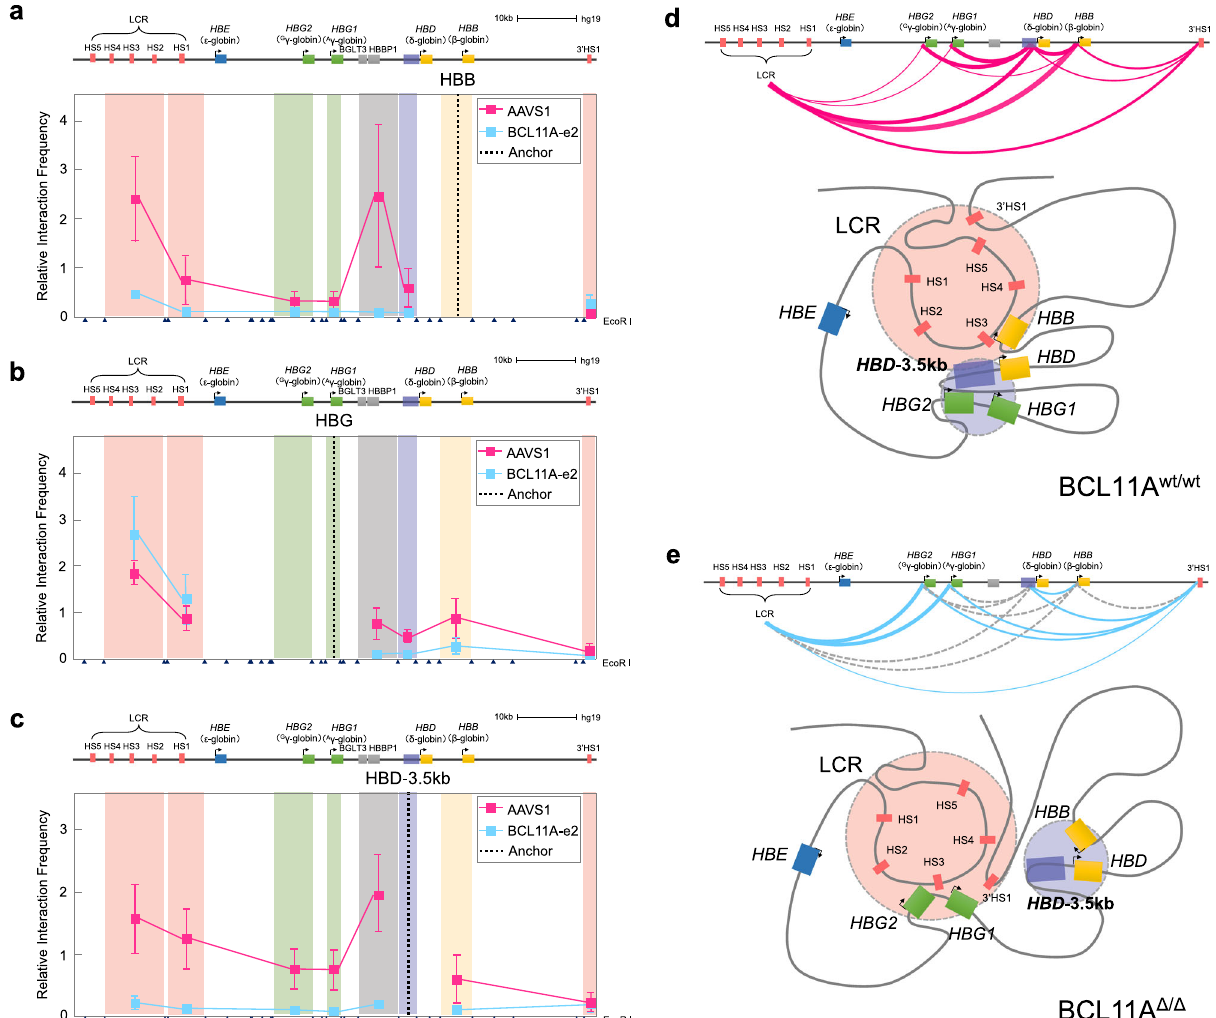
Fig. 5 Chromosome conformation capture analysis and a model for regulation of the β -globin locus by BCL11A to alter HbF expression. Chromosome conformation capture (3C) analysis was performed for HSPC-derived cell nuclei (AAVS1 and BCL11A exon 2 gRNA) at day 12 of erythroid differentiation. EcoRI cutting sites are shown at the bottom of each panel by triangles, and the designated anchors are plotted using dotted vertical lines. Relative interaction frequencies are shown for AAVS1 control in pink and BCL11A exon 2 editing in blue. Error bars indicate SEM from three biological replicates. a Relative interaction frequency between the HBB fragment as anchor and other regions of the β -globin locus. b Relative interaction frequency between the HBG fragment as anchor and other regions of the β -globin locus. c Relative interaction frequency between the HBD -3.5kb fragment as anchor and other regions of β -globin locus. d , e illustrate major long-range interactions at the top with a model of how these fi ndings translate to a model of chromatin conformation at the locus. Purple line: chromatin interaction in HUDEP-2 WT; blue line: chromatin interaction in BCL11A KO; gray dotted line: chromatin interaction loss in BCL11A KO compared to WT. The width of each line indicates the strength of chromatin interaction